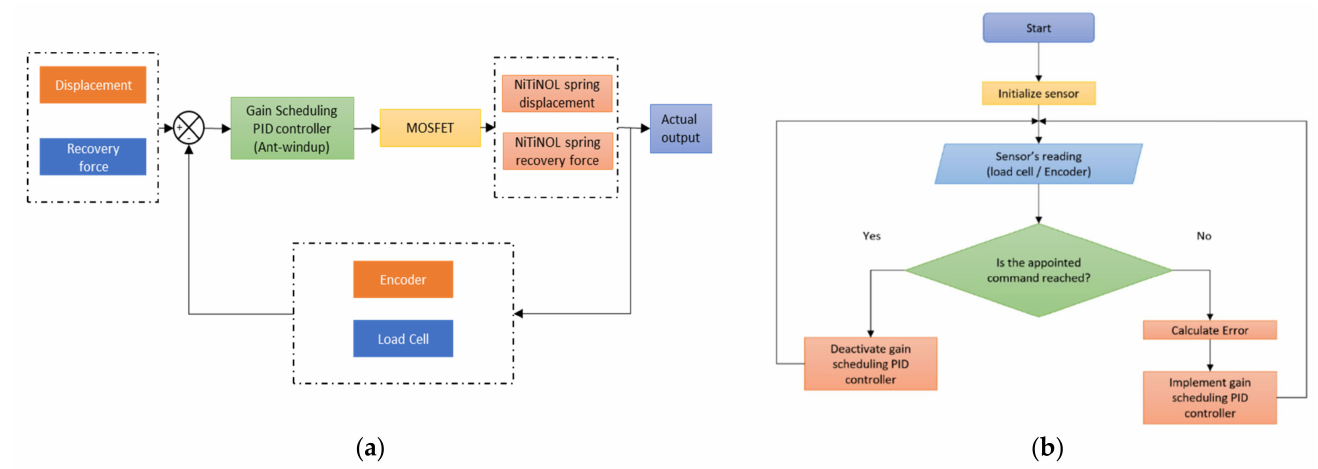
Figure 9. ( a ) Block diagram of the process gain scheduling PID controlled system, and ( b ) flow chart diagram of the controller working principle.